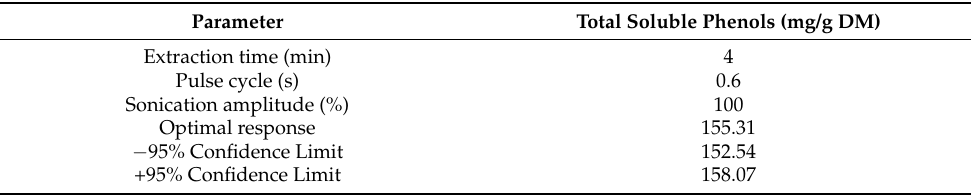
Table 3. Optimal conditions for ultrasonic-assisted extraction for the content of total soluble phenols from Psidium cattleianum leaf extracts obtained using the predicted